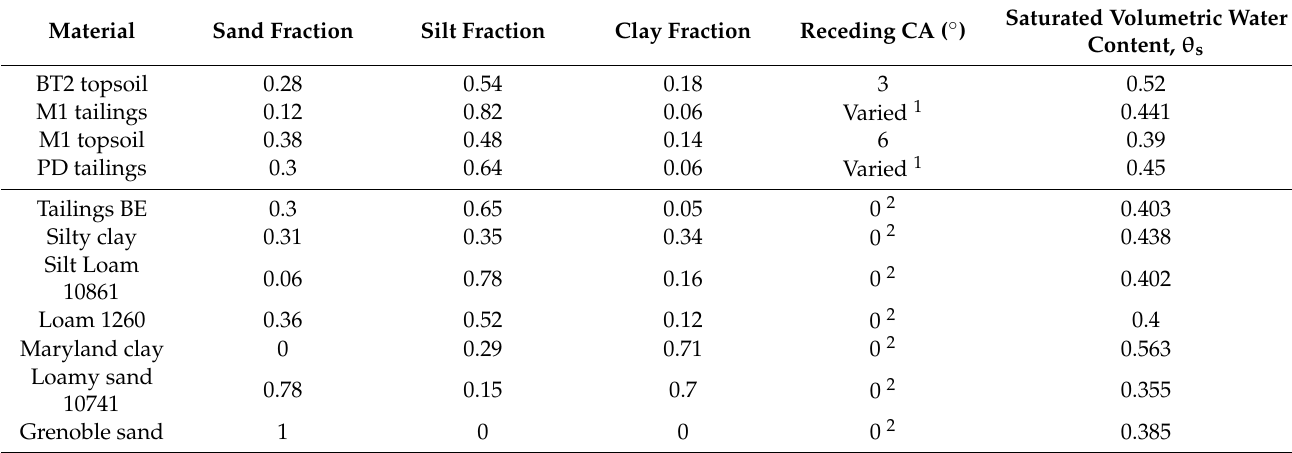
Table A2. Parameters used in the proposed model for each material: sand, silt and clay fraction, receding contact angle (CA), and saturated volumetric water content ( θ s